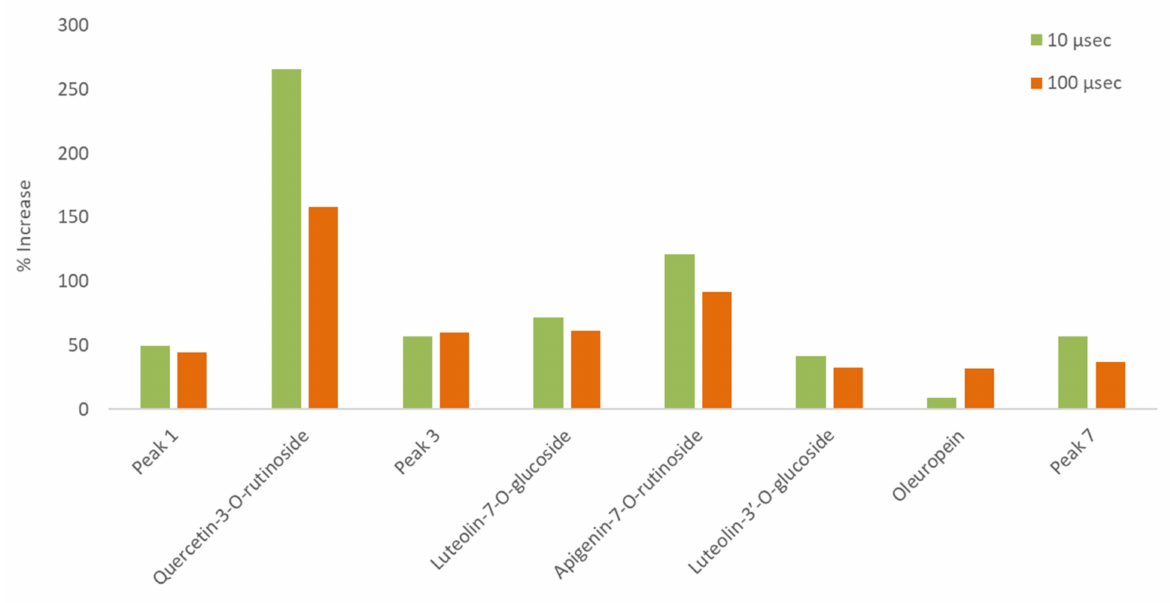
Figure 11. Comparison of the effect (% increase) of different pulse time durations on the extraction of various compounds in the same ethanol/water ratio (25%